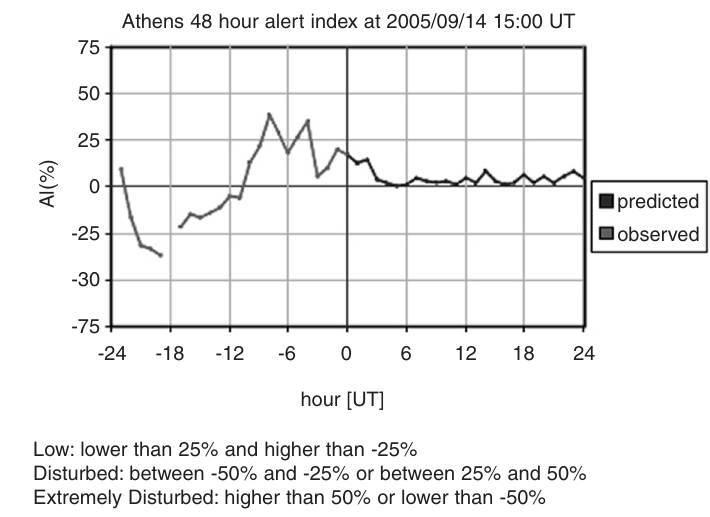
Fig. 10. Predicted and observed near-real time warning index (After DIAS Demo